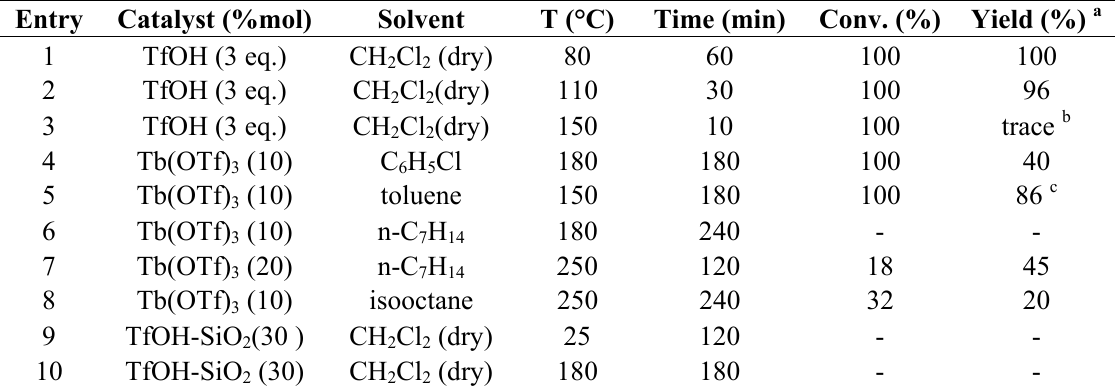
Table 2. Q-Tube method in the intramolecular Friedel-Craft acylation of 3-(4-methoxyphenyl) propionic acid 1 .